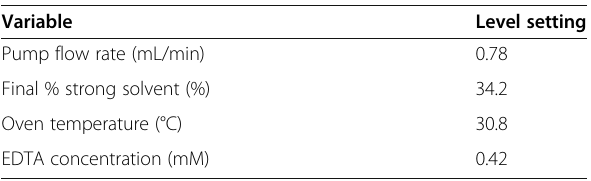
Table 3 Critical method parameter settings for the optimized method